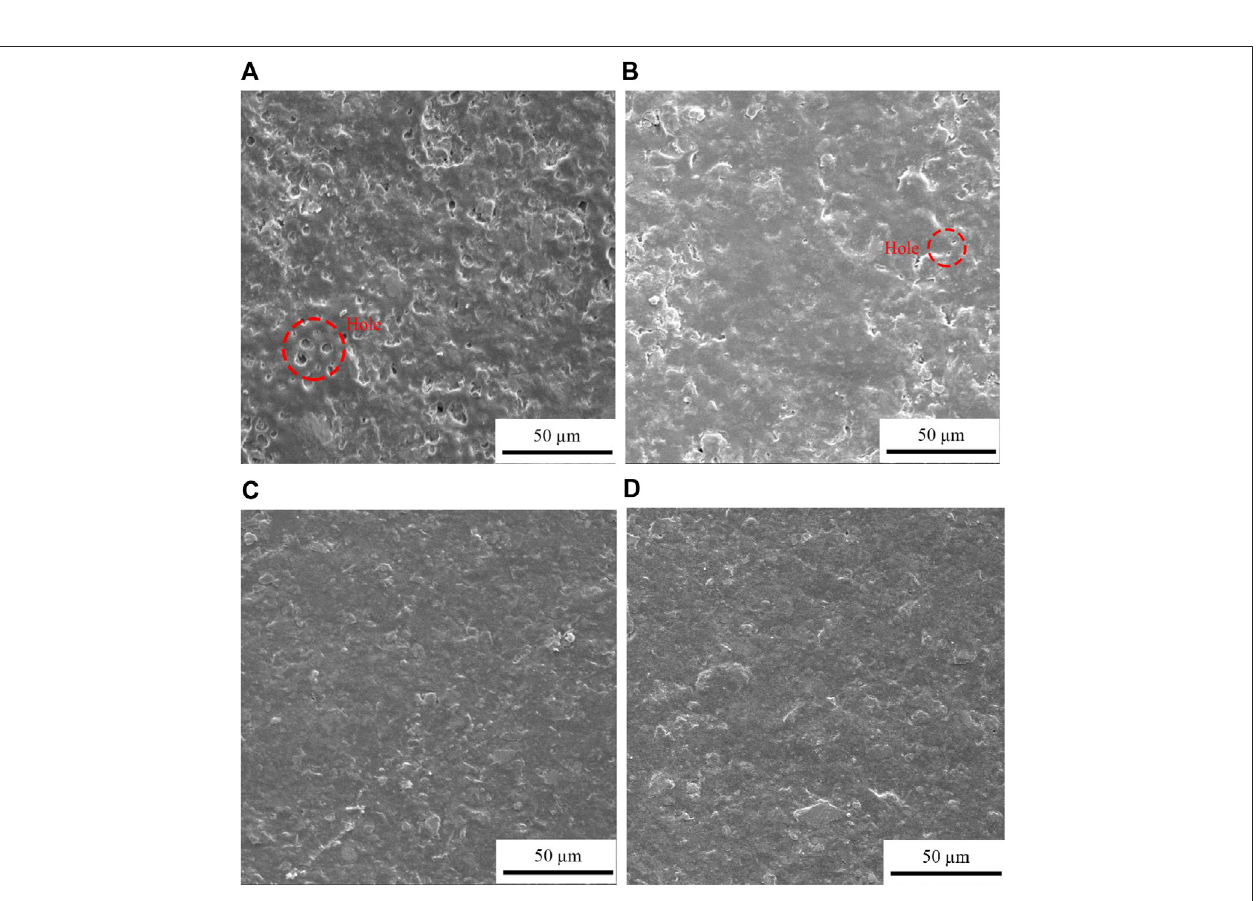
FIGURE7| Corrosion morphologyofmodi fi edoilyepoxy resincoatingwithdifferentgraphenecontent: (A) G/OEP-0wt%, (B) G/OEP-0.1 wt%, (C) G/OEP-0.3 wt %, (D) G/OEP-0.6 wt%.